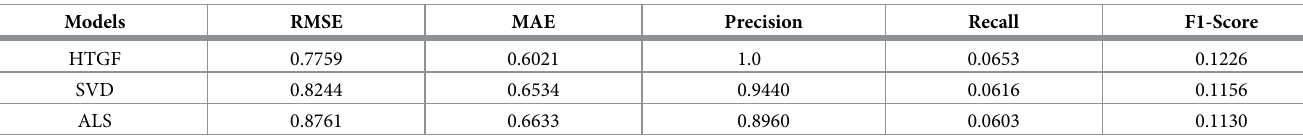
Table 13. Results. Models